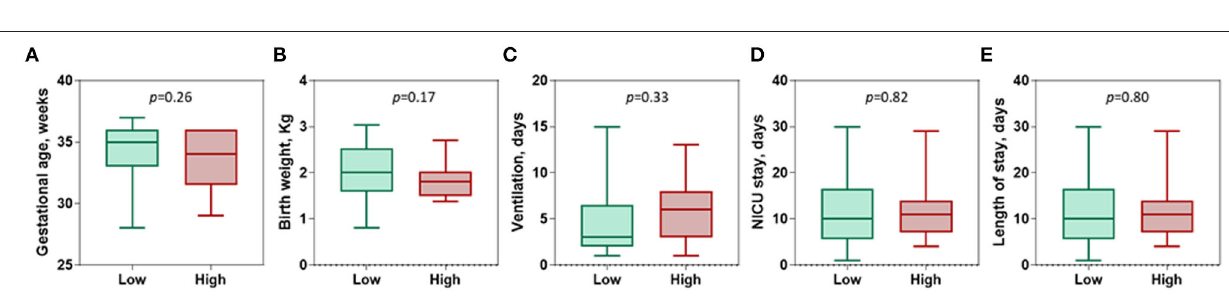
FIGURE 3 | Association of C1INH gene expression with disease characteristics. (A) Gestational age (weeks). (B) Birth weight (Kg). (C) Ventilation use (Days). (D) Neonatal intensive care unit (NICU) stay (days). (E) Length of stay (days). Patients were categorized according to the optimum log fold change of circulatory level of the C1INH gene of − 0.054 into low expression ( n = 67) and high levels ( n = 25). Mann-Whitney U -test was used. P -value was set significant at <